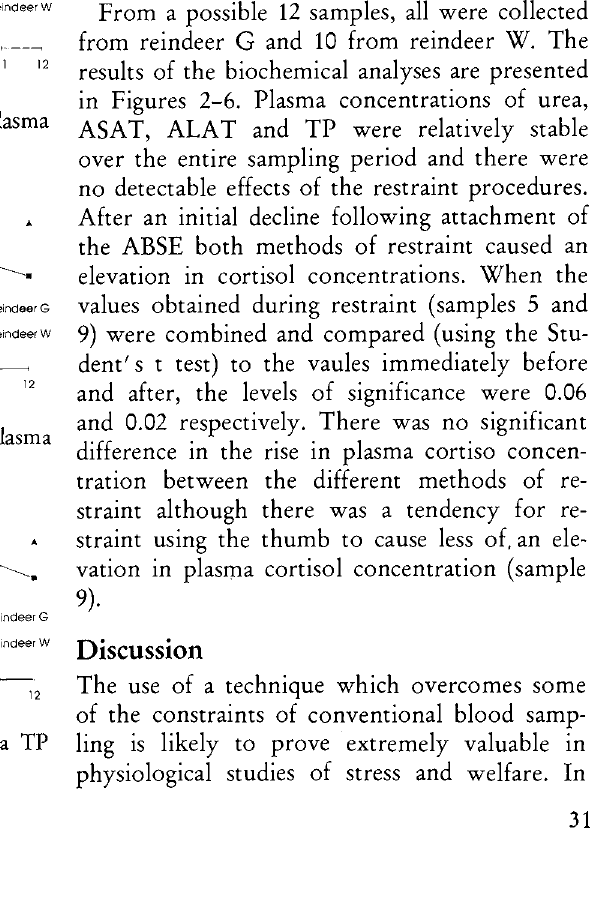
Fig. 4. Effect of restraint (at arrows) on plasma ASAT concentration.